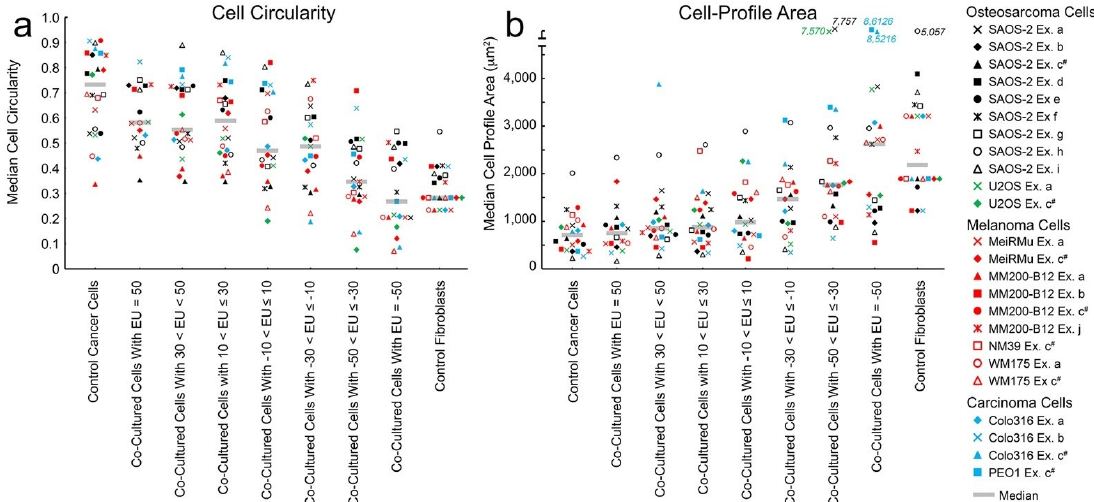
Figure 5. Median cell circularity measurements ( a ) and cell-profile area ( b ) of co-cultured cells grouped according to Exchange Units (EU) in Cartesian plots, as well as of control cancer cells and fibroblasts, across all 24 co-cultures studied in 10 separate experiments (Ex.). While median values for individual co-cultures are shown, medians across all experiments are also marked within each group by horizontal transparent grey lines. Symbols for co-cultures with SAOS-2 are in black, to aid visual separation from remaining co-cultures with other cancer cell lines. Fibroblasts were labelled with DiD in all experiments. Cancer cells were labelled with DiO, with the exception of experiment ‘i’ where SAOS-2 expressed GFP, and also in experiment ‘c’, which is marked c # in the legend and where the orientation of fluorescent labels was swapped. Statistical comparison between all groups shown are provided in Tables S21–S24 in Supplementary Materials. ( a ) Control cancer cells were more circular compared with co-cultured cells from 30 < EU ≤ 50 ( p < 0.003, Wilcoxon signed-rank test), through to EU = 50 ( p < 0.0001, Wilcoxon signed-rank test). While there was no statistically significant difference in circularity between EU = 50 cells and co-cultured cells in neighbouring groups of cells (30 < EU < 50; 10 < EU ≤ 30; − 10 < EU ≤ 10), EU = 50 cells were more circular compared with groups with EU < 10 ( p < 0.016, Wilcoxon signed-rank test). Co-cultured cells in the group 30 < EU < 50 were more circular, compared with all groups of co-cultured cells with EU ≤ 10 ( p < 0.05, Wilcoxon signed-tank test). Control fibroblasts were less circular in a statistically significant manner compared with all co-cultured groups of cells ( p < 0.05), other than compared with cells of EU = − 50. EU = − 50 cells were less circular compared with all other groups of co- cultured cells ( p < 0.009, Wilcoxon signed-rank test). Co-cultured cells in the group − 50 < EU ≤ − 30, were less circular compared with all groups with EU > − 30 ( p < 0.015, Wilcoxon signed-rank test); ( b ) control cancer cells had smaller median cell-profile areas compared with all groups of co-cultured cells ranging from 30 < EU < 50 ( p < 0.01, Wilcoxon signed-rank test), through to EU = 50 ( p < 0.0001, Wilcoxon signed-rank test). The co-cultured cell group with EU = 50 had lower cell-profile area compared with all other groups of co-cultured cells, and this reached statistical significance for 30 < EU < 50 ( p < 0.035, Wilcoxon signed-rank test), and for groups where EU ≤ − 10 ( p < 0.003, Wilcoxon signed-rank test). Co-cultured cells in the group 30 < EU < 50 had lower cell-profile area compared with all groups with EU ≤ 30, but this only reached statistical significance where EU ≤ −